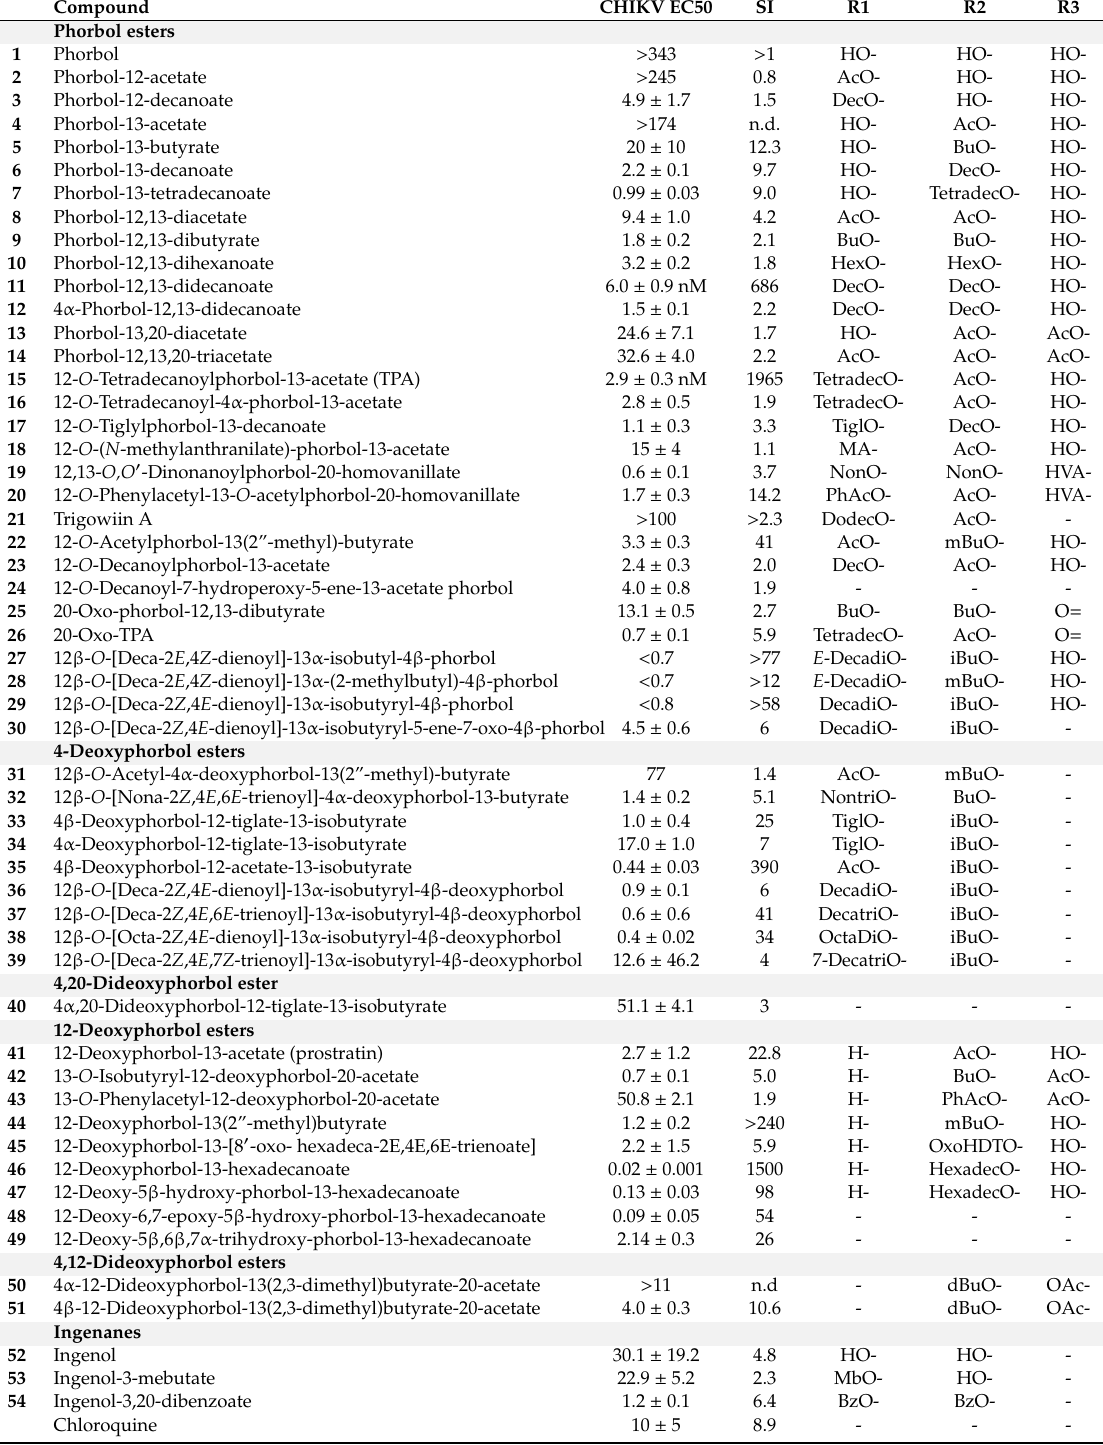
Table 1. Anti-chikungunya virus (CHIKV) activities of tiglianes 1 – 51 and ingenanes 52 – 54 .